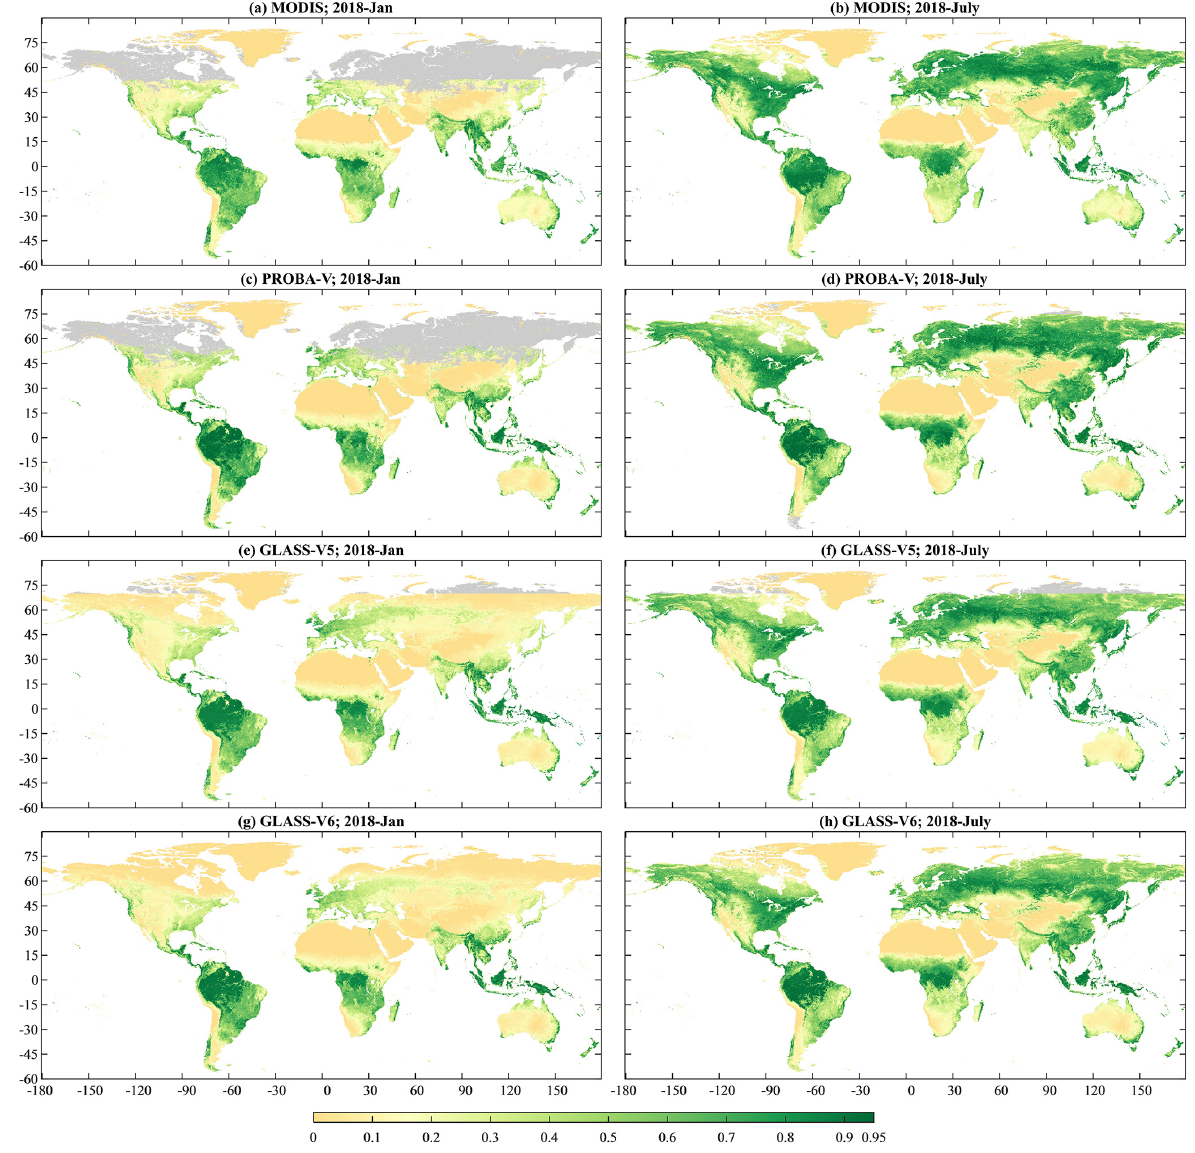
Figure 7. Global spatial distributions of the MODIS, PROB-V, GLASS V5, and GLASS V6 FAPARs in January and July of 2018: (a) MODIS, January 2018; (b) MODIS, July 2018; (c) PROBA-V, January 2018; (d) PROBA-V, July 2018; (e) GLASS V5, January 2018; (f) GLASS V5, July 2018; (g) GLASS V6, January 2018; and (h) GLASS V6, July 2018. The spatial resolution is 0.05 ◦ latitude and longitude.